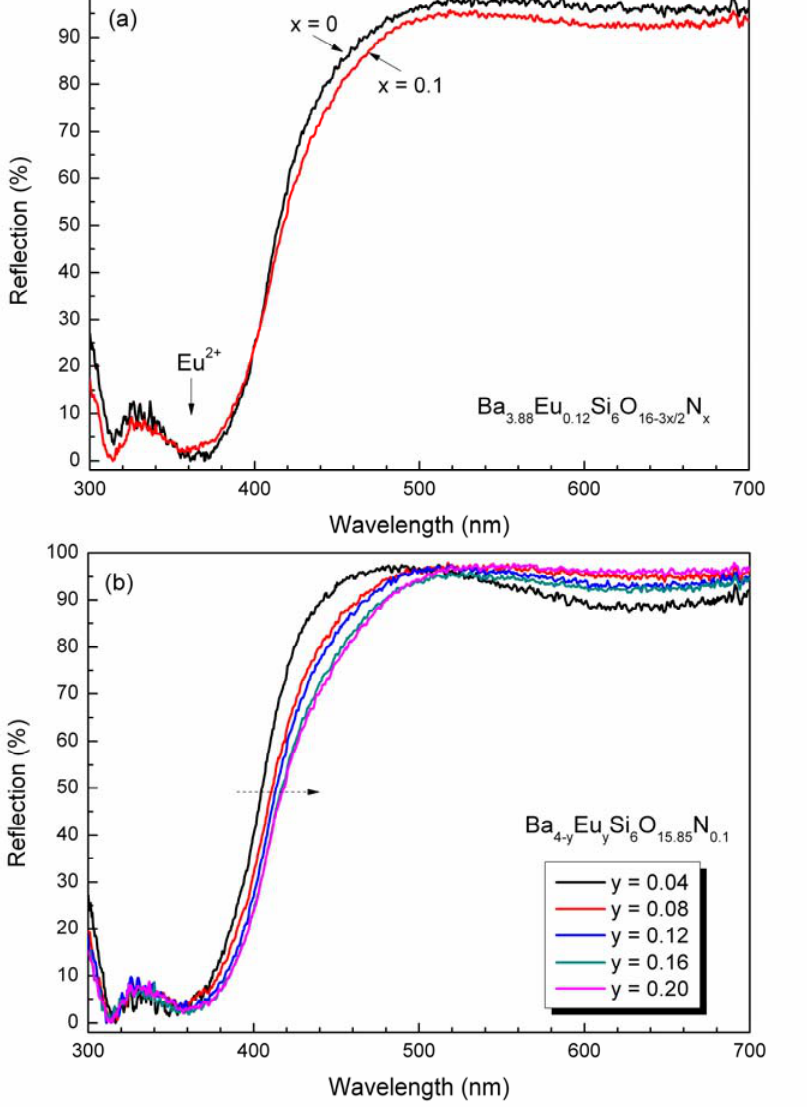
Eu Si O N as the function of (a) the 4-y y 6 16-3x/2 x